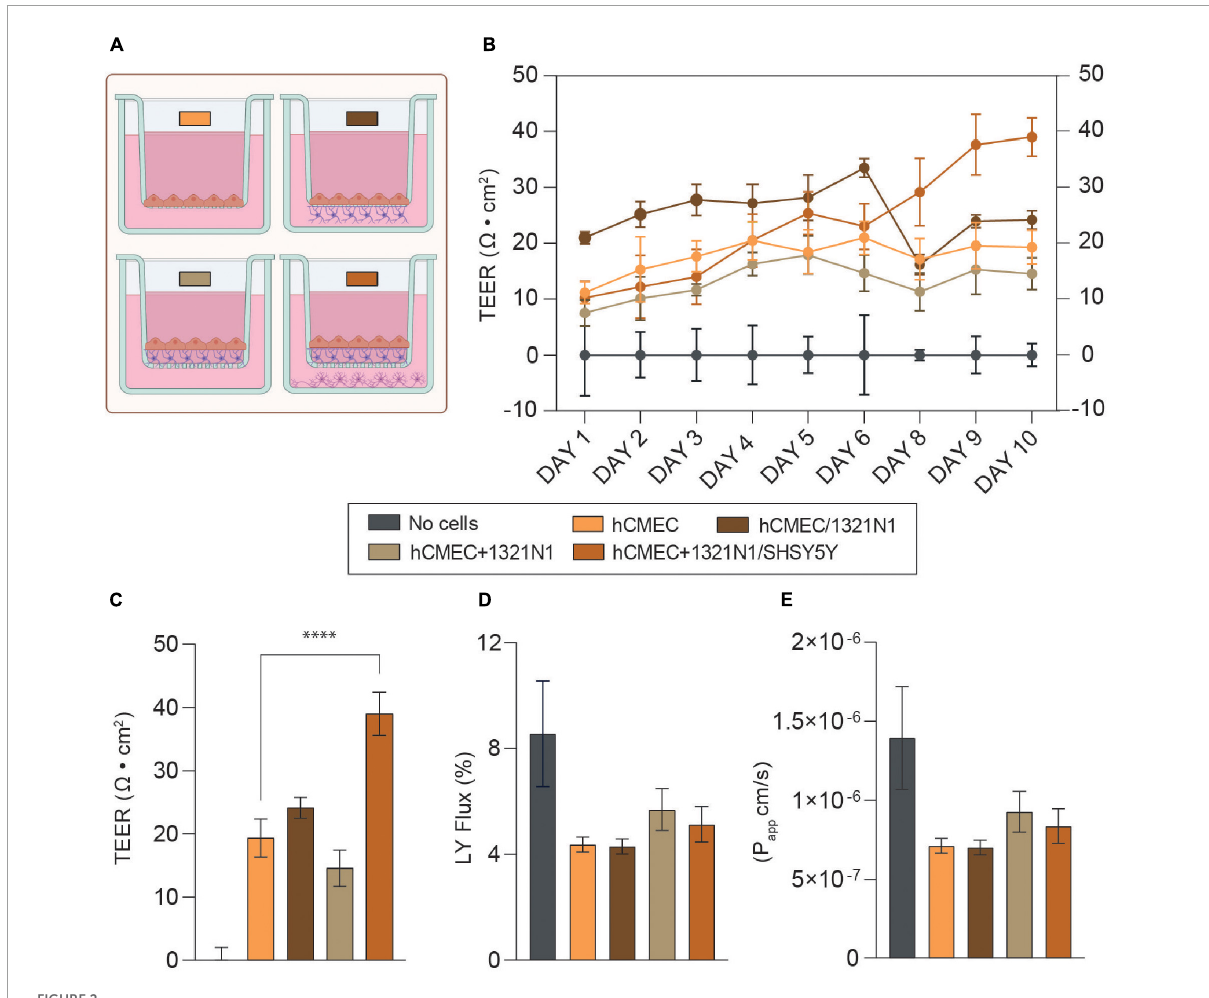
FIGURE2 (A) Schematics of the neurovascular unit (NVU) setups used for EVOM measurements and permeability assay. The color code refers to the legend in this figure. Created with Biorender.com. (B) Mean transendothelial electrical resistance (TEER) values ( (cid:127) cm 2 ) for hCMEC in monoculture, hCMEC, and 1321N1 co-culture (hCMEC/1321N1 as “indirect” contact and hCMEC+1321N1 as “contact” co-culture) and hCMEC+1321N1/SHSY5Y tri-culture. Measurements were performed daily for 10 days from Transwell inserts in 24-wellplates (pore size 0.4 µ m, area 0.33 cm 2 ). (C) Bar chart representing TEER values at day 10 post-seeding in all NVU model setups. The difference between monoculture, co- and tri-culture was assessed using a one-way ANOVA with ∗∗∗∗ p < 0.0001. The error bars represent the standard deviation of at least 3 replicates for each condition (mean ± SD). (D,E) Lucifer yellow (LY) flux and apparent permeability (Papp) bar charts for monoculture, co-culture, and tri-culture, showing low paracellular permeability to LY ( < 1 × 10 - 6 cm/s) in all the conditions in the range of values observed elsewhere. The error bars represent the standard deviation of at least 3 replicates for each condition (mean ±